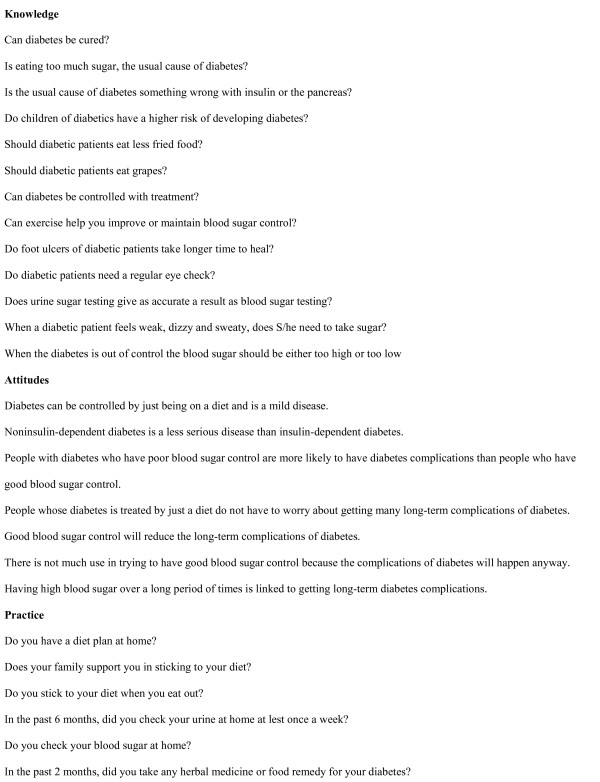
Questions asked to assess knowledge, attitudes and practice about diabetes.